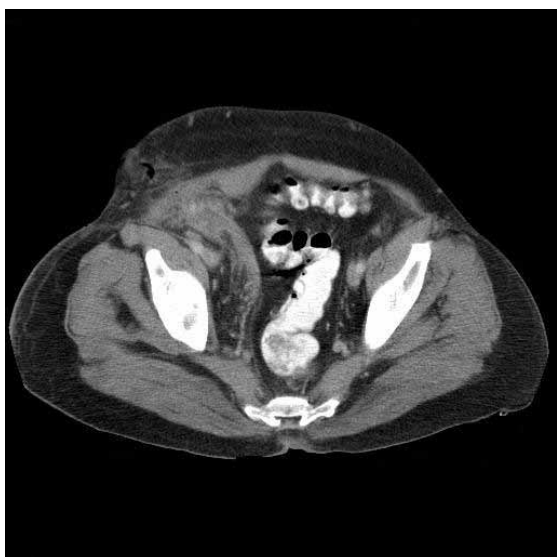
Figure 2. Right inguinal canal with a fluid collection from the head of the